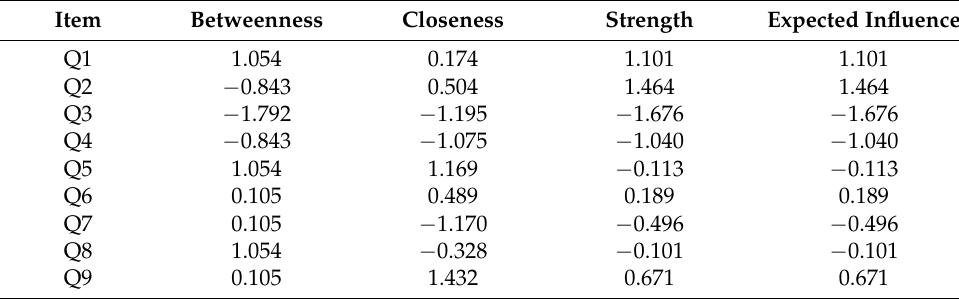
Figure 2. Centrality indices of the network of responses to depression in SMC. A high strength and expected influence values suggest that a node is positively associated with other nodes in the network (i.e., an increase in the value of that node is associated with an increase in the value of other nodes). Feeling down (PHQ-9 item 2) and having little interest or pleasure in doing things (PHQ-9 item 1) emerged as the most highly central symptoms. Table 2. Centrality measures per variable in SMC.